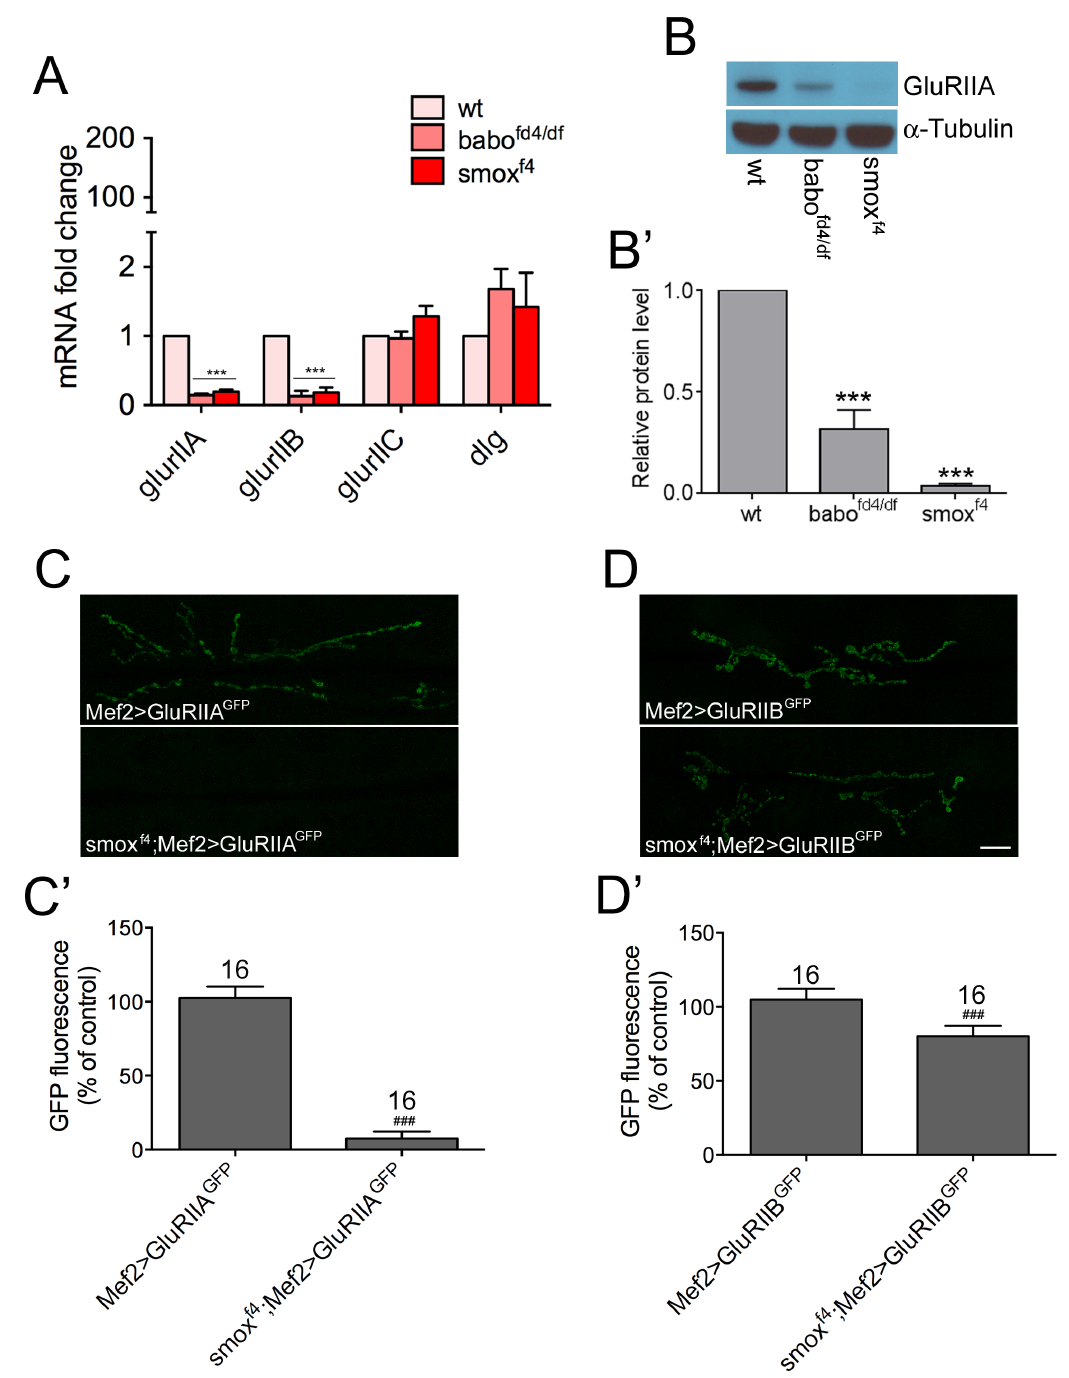
Figure 4. Synaptic GluRIIA and GluRIIB abundances are differentially regulated by Activin/TGF- b pathway. (A) Transcript levels of glurIIA , glurIIB, glurIIC and dlg . Results from qRT-PCR assay demonstrate significant decreases in the levels of glurIIA and glurIIB transcripts in babo and smox mutants. (B and B 9 ) Total protein level of GluRIIA. A representative blot (B) and quantification (B 9 ). (C and C 9 ) Exogenous expression of glurIIA-gfp in wild-type and smox mutant backgrounds. Representative confocal images (C) and quantification (C 9 ) of GFP activity at the synapses. (D and D 9 ) Exogenous expression of glurIIB-gfp . Representative confocal images (D) and quantification (D 9 ) of GFP activity at the synapses. ***p , 0.001 from One-way ANOVA followed by Dunnett’s multiple comparison test. ### p , 0.001 from unpaired t-test. Error bars represent SEM. Scale bar equals 20 m m. doi:10.1371/journal.pone.0107443.g004 TGF- b signaling influences the accumulation of presynaptic mutants (Fig. S4A and A 9 ). Additionally, we counted the Brp molecules. In contrast to the postsynaptic components, deposition puncta that have been proposed to represent active zones. The of Brp at the synapses was not decreased in the babo and smox number of Brp puncta was then normalized to the synaptic area